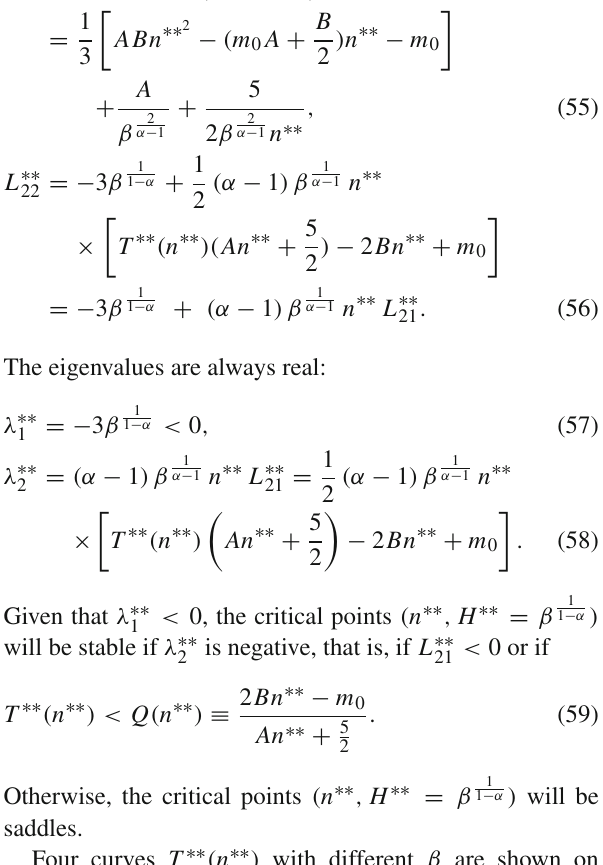
. The n ∗∗ - Fig. 3c, intersects the n ∗∗ -axis at points ν ∗∗ 1 , 2 coordinates of the intersection point of T ∗∗ ( n ∗∗ ) with the . As, while negative, T ∗∗ ( n ∗∗ ) can- curve Q ( n ∗∗ ) are σ ∗∗ 1 , 2 not intersect the strictly positive T ( n ∗∗ ) , no critical points ( n ∗∗ , H ∗∗ = β 1 /( 1 − α) ) can exist for T ∗∗ ( n ∗∗ ) < 0. Thus, < stable critical points for β > β 0 exist in the interval ν ∗∗ 2 n ∗∗ < σ ∗∗ – where the non-negative T ∗∗ ( n ∗∗ ) is smaller than 2 Q ( n ∗∗ ) . When β = β 0 , the curve T ∗∗ ( n ∗∗ ) , marked with (ii) = n ∗∗ – on Fig. 3c, is tangent to the n ∗∗ -axis at point χ ∗∗ 1 0 the point at which Q ( n ∗∗ ) crosses the abscissa. This curve . Critical intersects the curve Q ( n ∗∗ ) further – at point χ ∗∗ 2